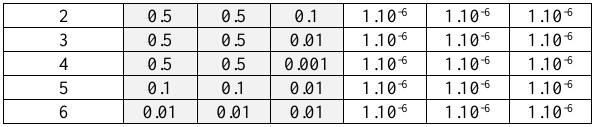
(In red) values that caused trajectory deviation Table 2. Variation in the standard deviations of the polynomial parameters related to acceleration used in the weighted constraints.